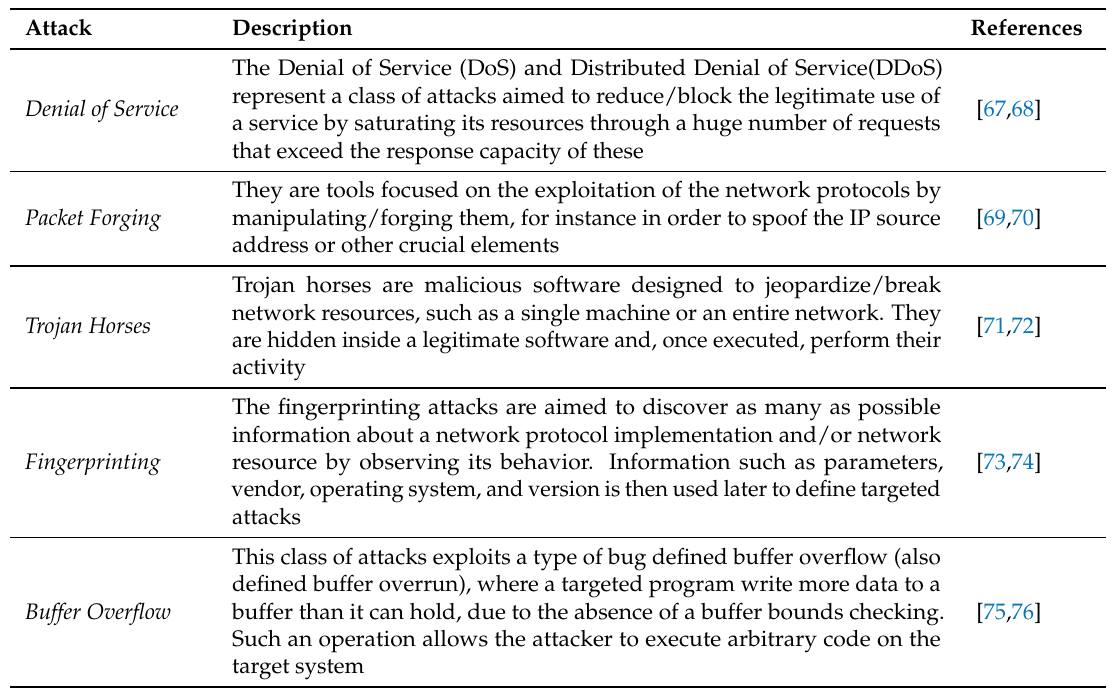
Table 2. Common classes of network